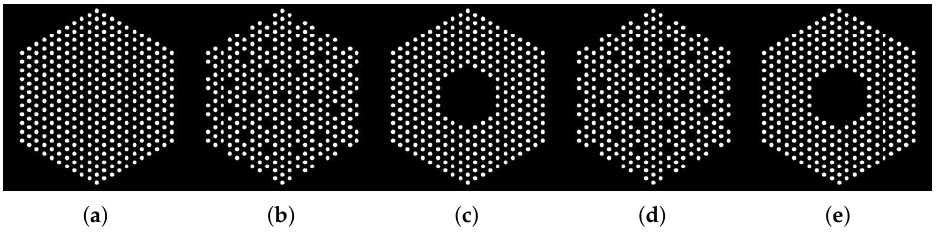
Figure 9. Actual binary masks of the simulated fuel assemblies. ( a ) Case “1”, ( b ) Case “2”, ( c ) Case “3”, ( d ) Case “4”, ( e ) Case “5”. In Case “1”, the mock-up fuel assembly hosted 331 60 Co pins of 8.879 g/cm 3 density, which emitted 1.17 and 1.33 MeV gamma rays. In Cases “2” and “3”, 10% 60 Co pins pins were removed at the center or uniformly. In Cases “4” and “5”, 10% 60 Co pins pins were replaced by depleted uranium pins of the same size but higher density (10.4 g/cm 3 ) and no activity.